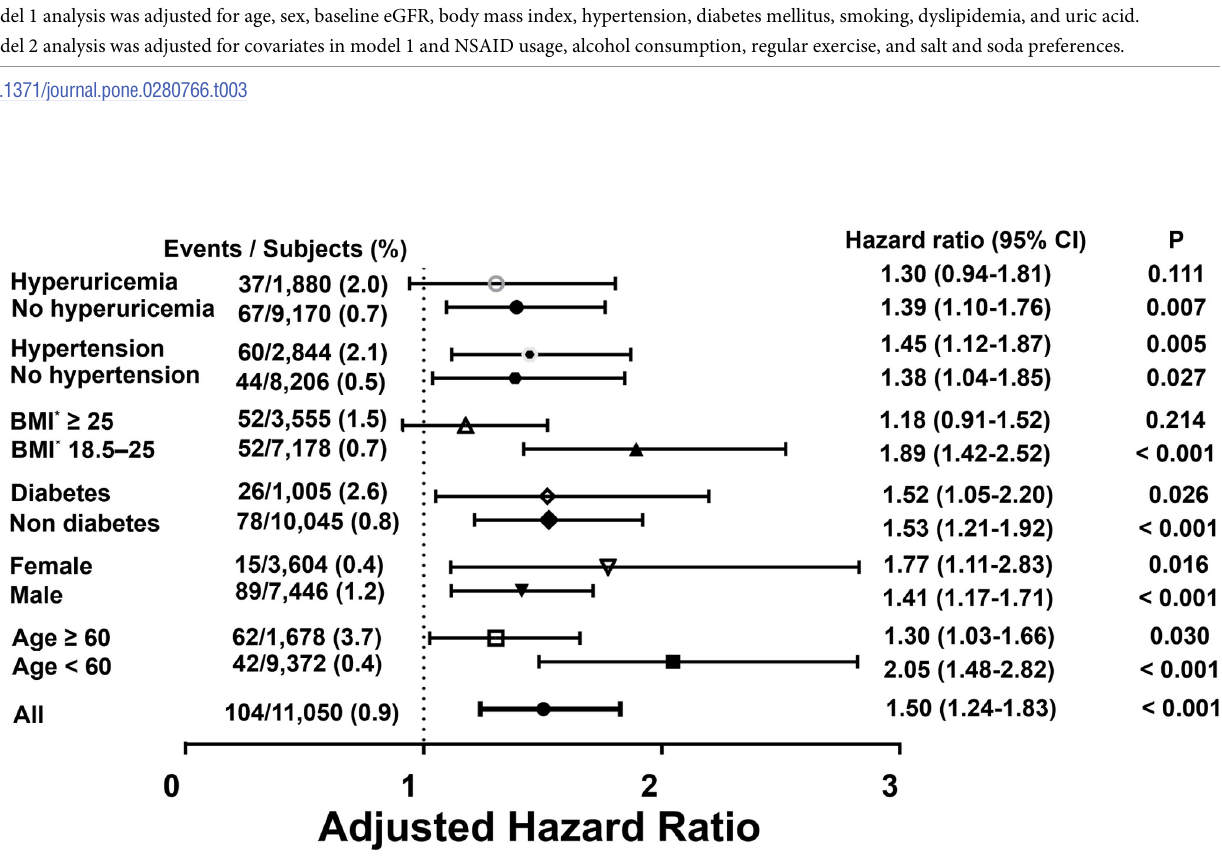
Fig 2. Forest plot for the risk of chronic kidney disease development due to the increased visceral adipose tissue area. The risk of CKD development associated with standardized visceral adipose tissue (continuous variables with a mean of zero and standard deviation of 1 in each subgroup) was compared according to age, sex, diabetes mellitus, and BMI. CKD, chronic kidney disease; BMI, body mass index. � In the subgroup analysis stratified by body mass index, underweight populations (BMI < 18.5, n = 317) among the whole participants were